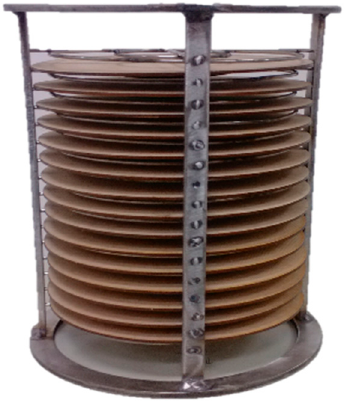
Figure 1. Polymer pressboard specimens used in our experiments.